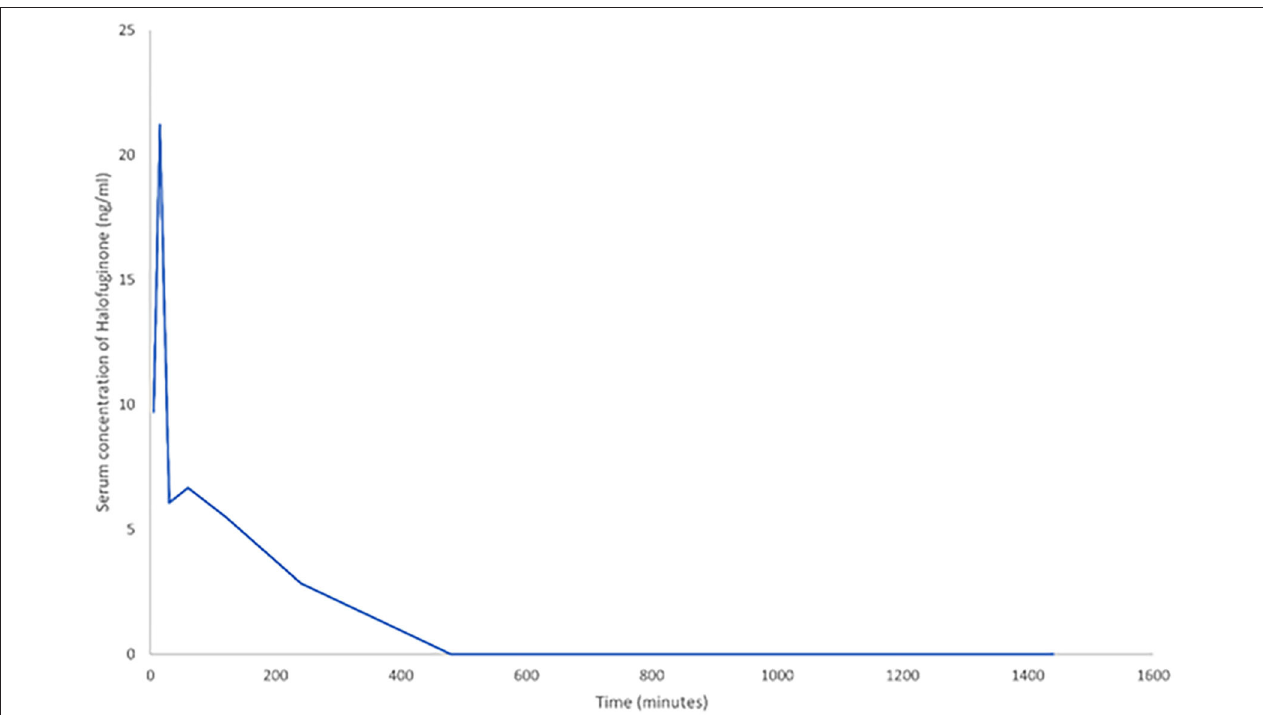
FIGURE 1 | A line graph demonstrating the change in serum halofuginone post-intraperitoneal (IP) administration of 7.5 µ g ( n = 4). To allow inclusion of all time points, time is measured in minutes. The last five data points are at 1, 2, 4, 8, and 24h respectively.